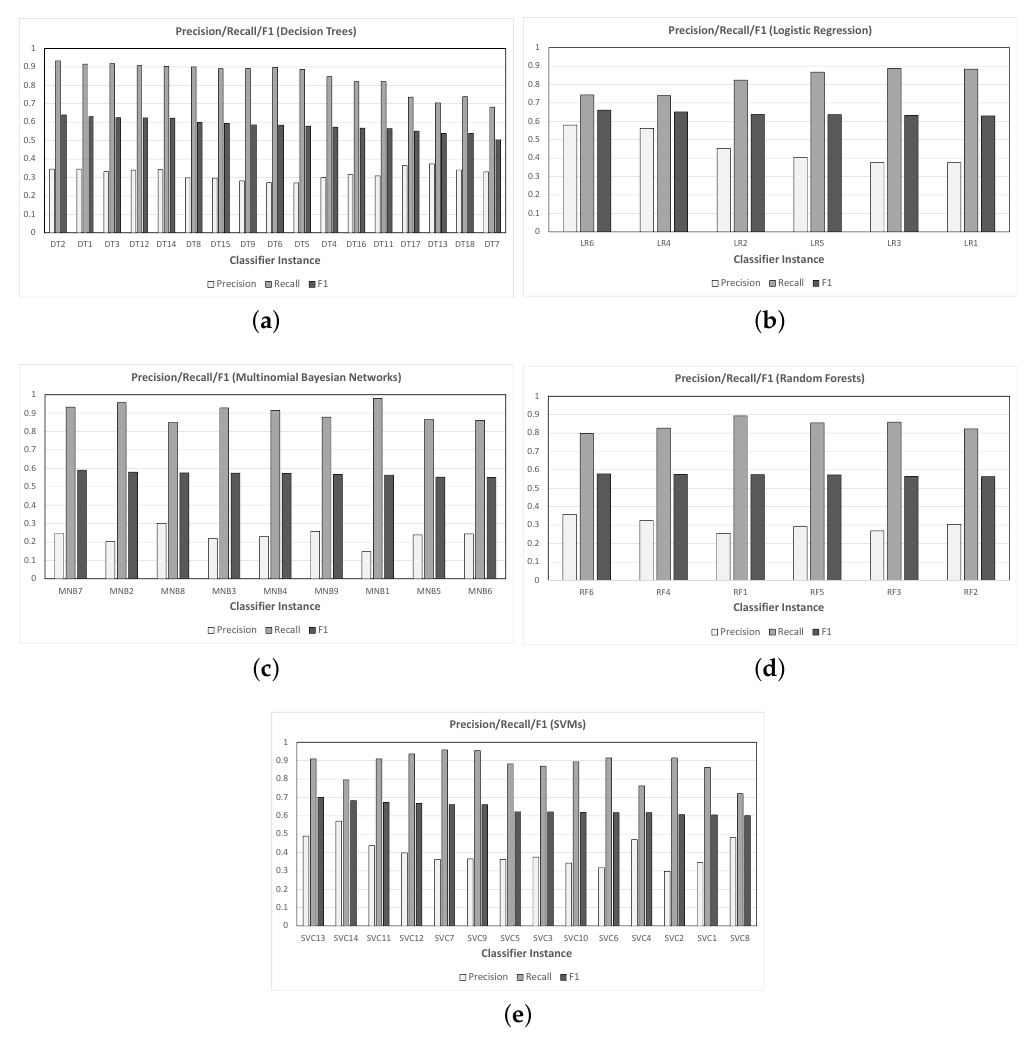
Figure 3. Precision, recall, and F1 values for all classifiers evaluated in Phase 1: ( a ) Decision Trees, ( b ) Logistic Regression, ( c ) Multinomial Bayesian Networks, ( d ) Random Forests, and ( e ) Support Vector Machines. In each graph, classifier instances are sorted in descending order of F1 measure.